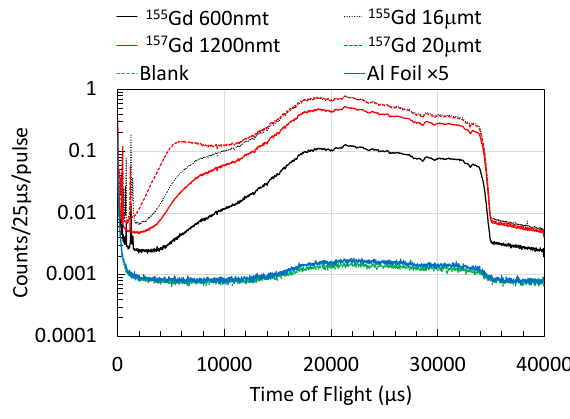
Figure 1. TOF spectra of the 155 Gd and 157 Gd samples, the Al foils and Blank. The TOF time bin is 25 µ s. Each TOF spectrum was normalized with the number of the proton beam pulses.